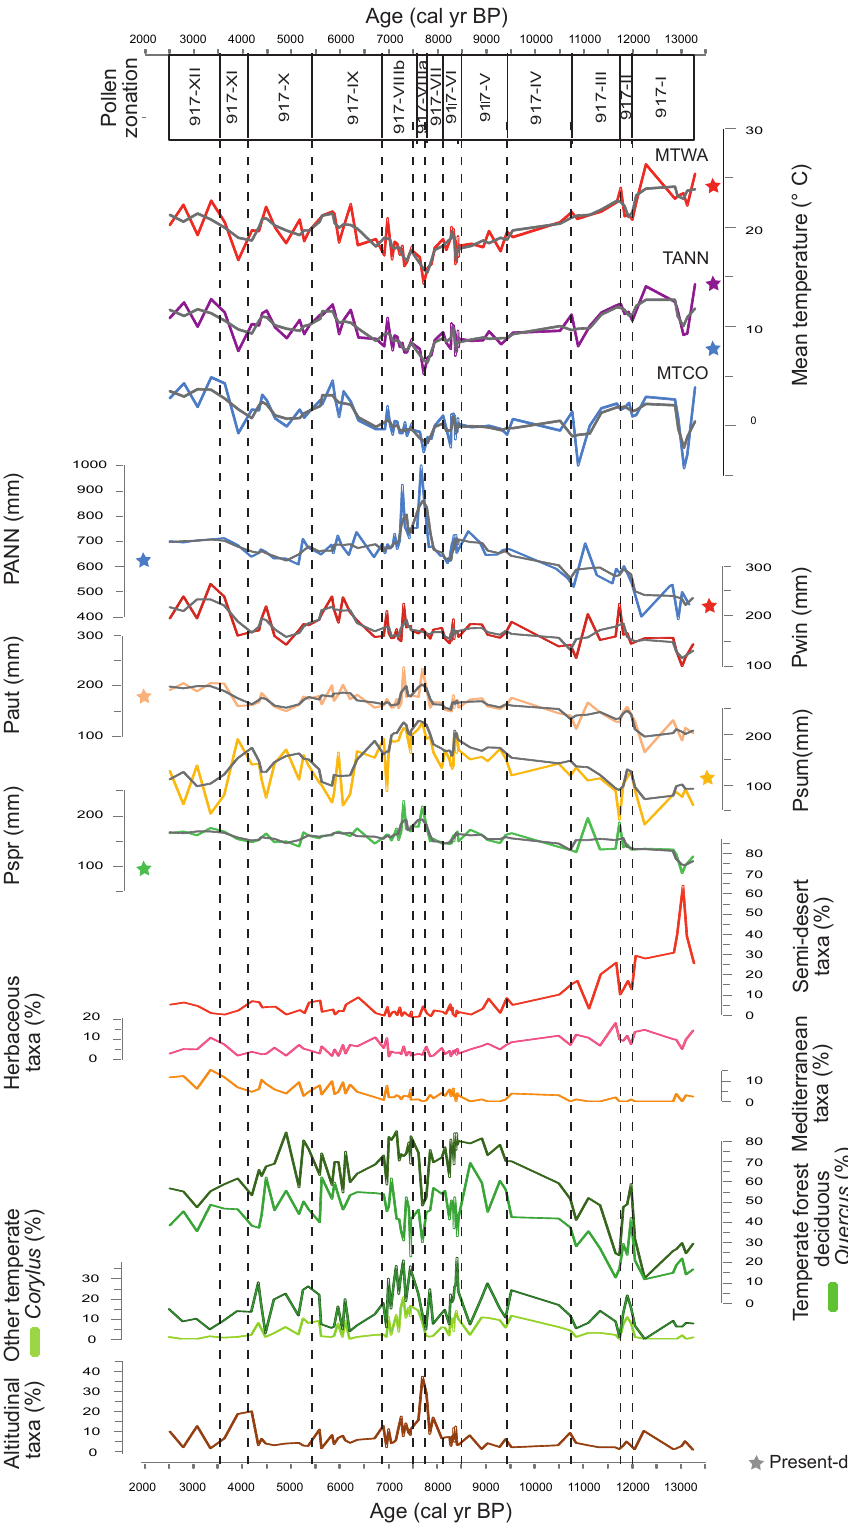
Fig. 4. Selected pollen curves of core MD 90-917 and pollen based reconstruction of precipitation (seasonal: Pspr, Psum, Paut, Pwin and annual: PANN) and temperature ( MTCO, MTWA and TANN). All curves are presented in cal yr BP. Grey curves are the 3 pts-smoothed curves. Colored stars represent the present-day values for each climate